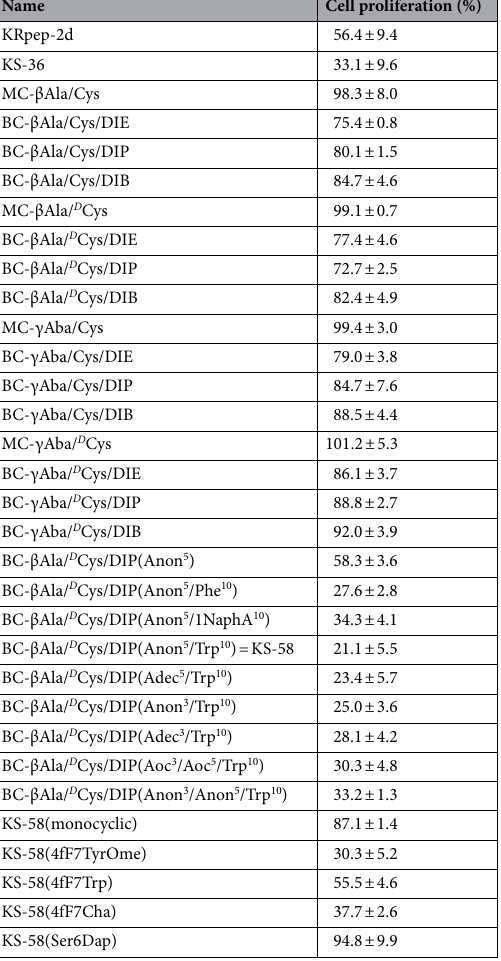
Table 1. Cell proliferation rate of A427 cells in the presence of peptide. Peptide concentration was 30 µM (n = 4, ± SEM). Peptide name is basically given as MC-X/Z or BC-X/Z/liker, wherein MC means monocyclization, BC means bicyclization, X is the N-terminus first amino acid, and Z is the C-terminus last amino acid